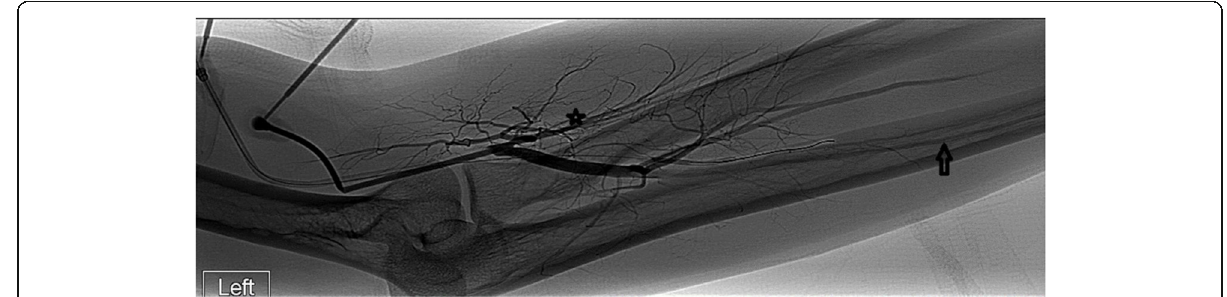
Fig. 1 Pre-creation left brachial arteriogram in a 27-year-old man with ESRD. The radial artery (star) is diminutive in its proximal aspect and occluded in the mid forearm with flow in the hand from the ulnar artery (arrow) & interosseous